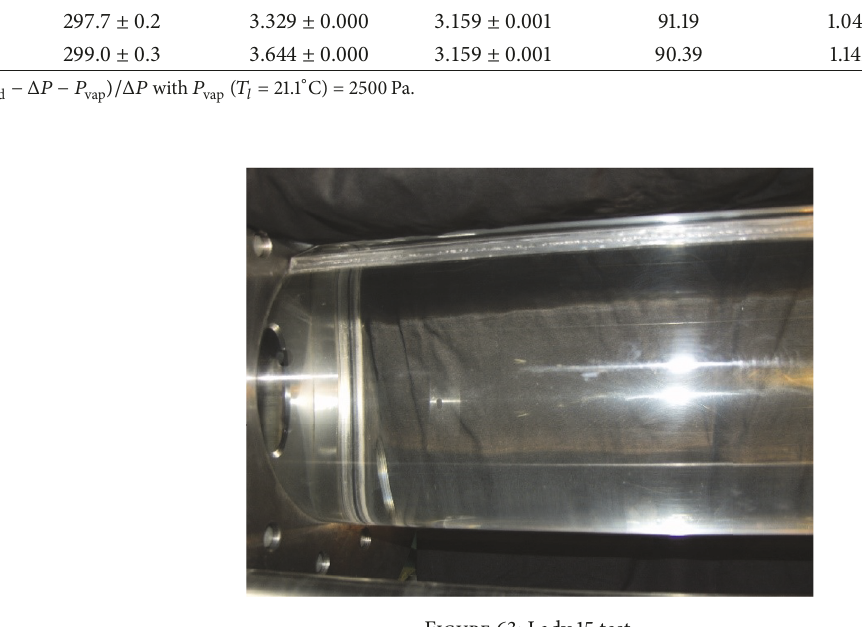
Figure 63: Lady 15 test.